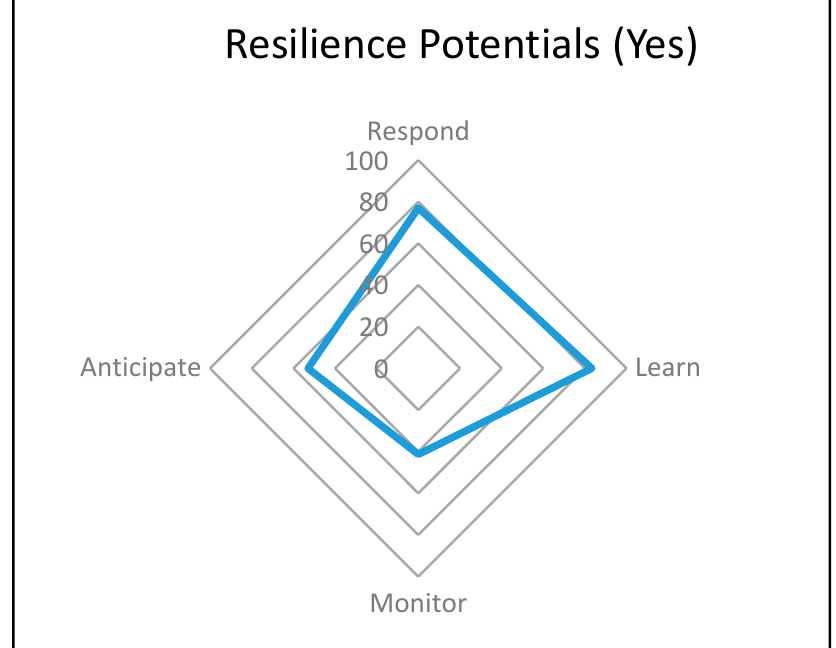
Figure 6. Four potentials as a percentage of Yes responses.